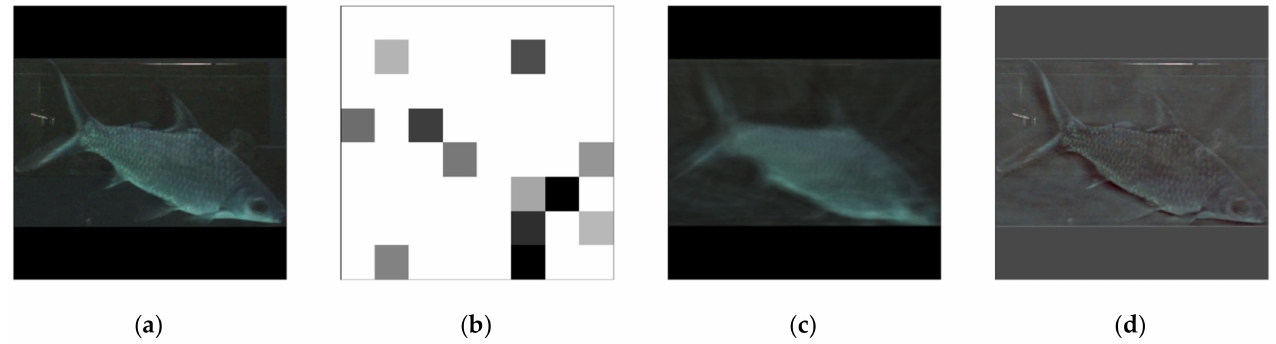
Figure 4. The MLP autoencoder sample results: ( a ) source, ( b ) latent, ( c ) reconstructed, and ( d ) difference.